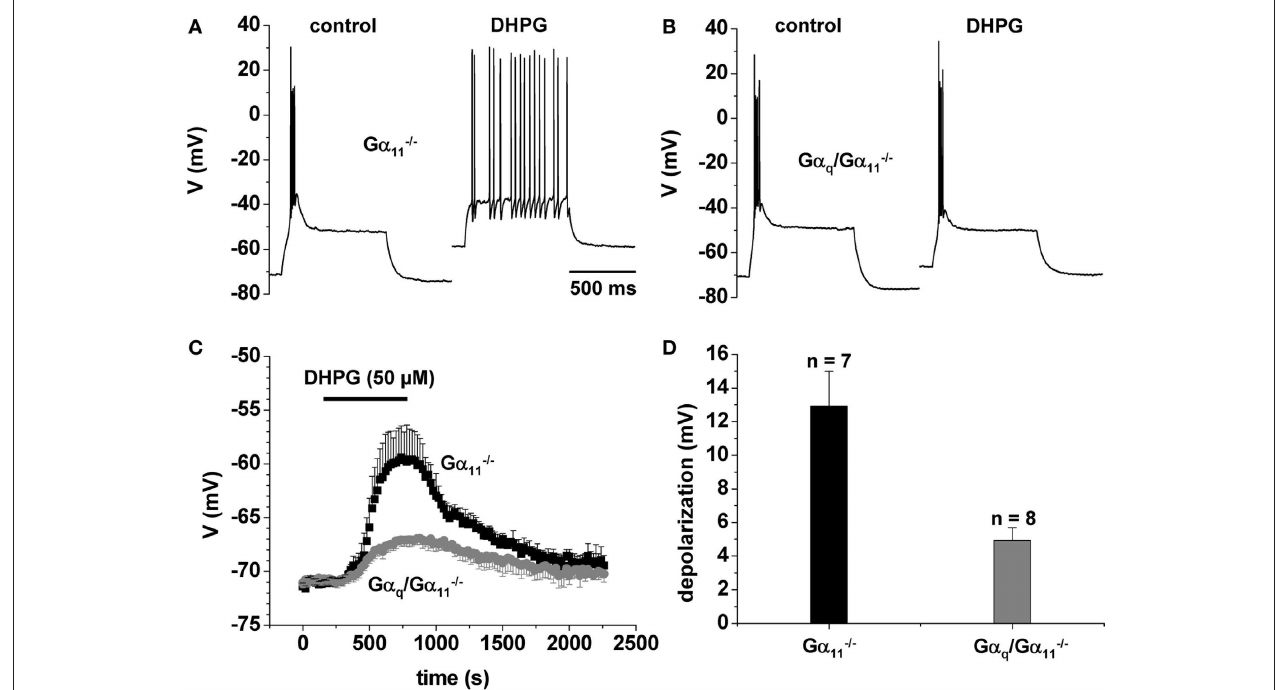
FiGure 3 | DHPG effect on firing properties. (A,B) Functional consequences of DHPG administration during current clamp recordings in a control mouse (A) and in G α /G α − / − (B) . (C) Mean voltage vs. time plot (black squares, control animal; gray circles, G α q 11 bar graph representation of the DHPG-induced